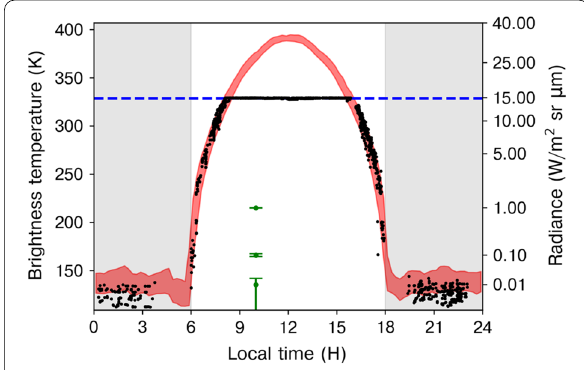
Fig. 5 Comparison of the equatorial brightness temperature measured by AHI at band 11 with Diviner GCP at channel 5. The gray and white areas correspond to the nightside and dayside, respectively. The red area shows the time variation of average brightness with a standard deviation range of Diviner GCP from 5°N to 5°S. The black points are the brightness temperatures of the HSD pixels which correspond to lunar latitude from 5°N to 5°S and emission angle smaller than 5°. Note that HSD is saturated at the blue dashed line. Each green bar indicates the background noise level from the broad PSF at the radiance of 0.01, 0.1, and 1 W/m 2